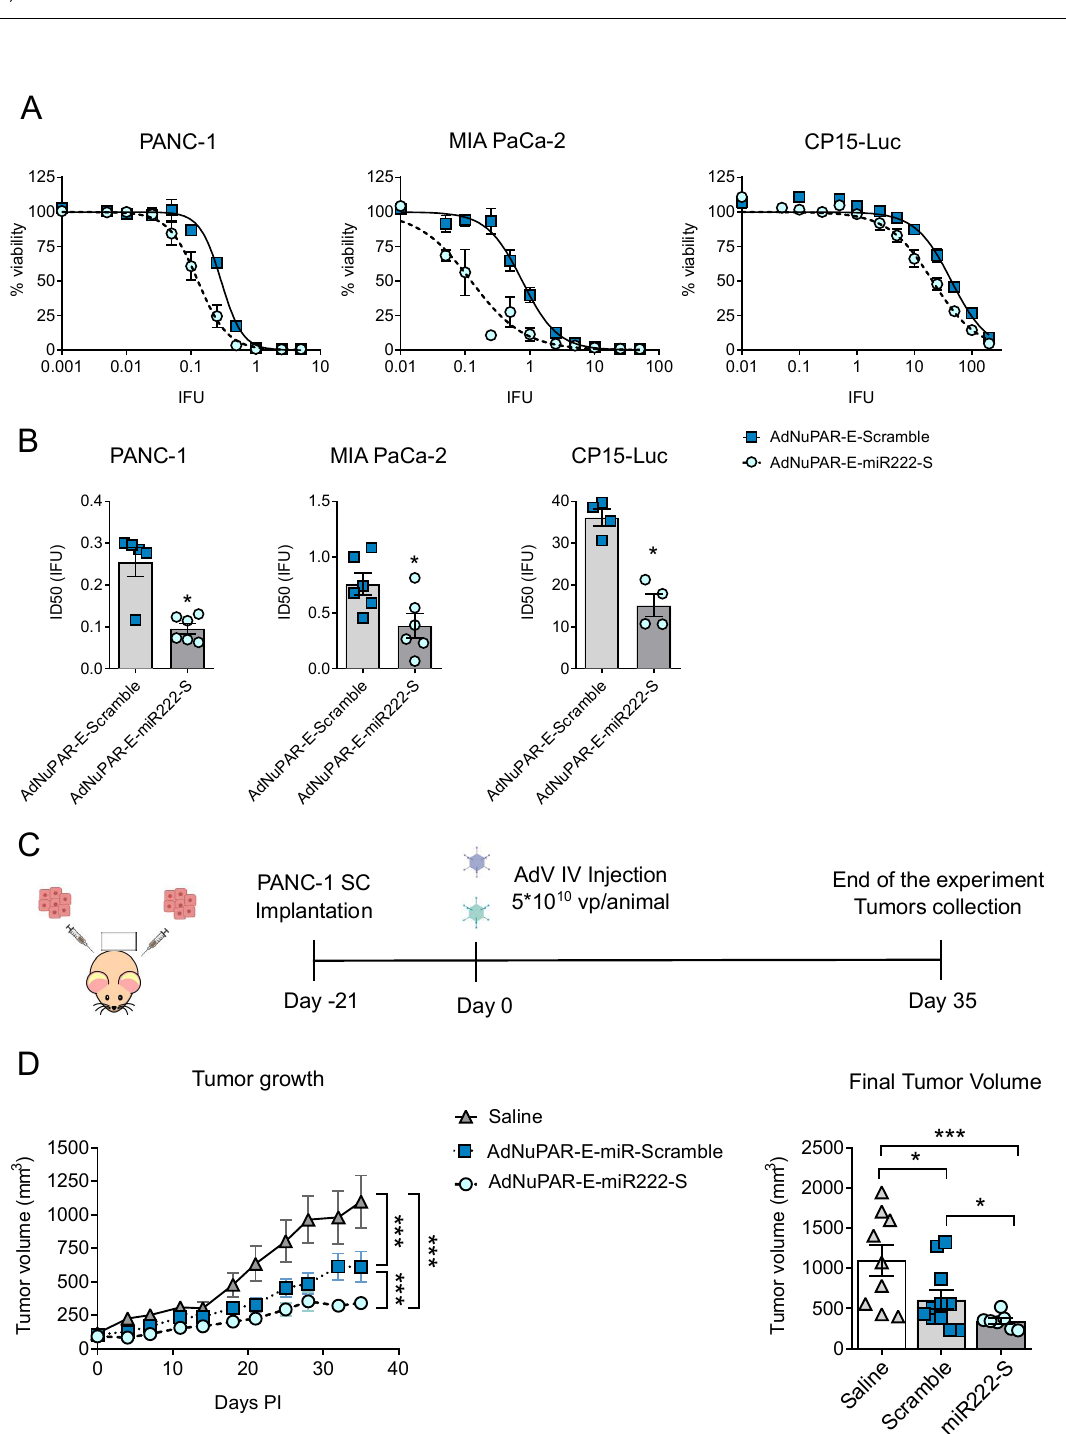
Figure 6. AdNuPAR-E-miR222-S oncolytic potency in vitro and antitumor activity in vivo. ( A ) Viability Curves in PANC-1, MIA PaCa-2, and CP15-Luc cell lines. Cells were infected with AdNuPAR-E-Scramble or AdNuPAR-E-miR222-S at the indicated viral doses and cell viability was measured 7 days later by an MTT assay. ( B ) ID50 values for the three PDAC cell lines. Values are expressed as mean ± SEM of at least four independent biological replicates. ( C ) Schematic representation of the in vivo experiment. ( D ) Tumor growth follow-up. Left panel shows growth curves for the different treatments. Right panel shows mean tumor volumes on day 35 for each group. Data are shown as mean ± SEM. ( n ≥ 8 tumors/treatment group). Statistical differences in tumor growth ( D ) were evaluated using a multiple comparison of means by Tukey contrast, analyzed with the R v.2.14.1 software, applying a linear mixed-effect model using the Ime4 package. p < 0.05 was taken as the level of significance. For the remaining graphs significance was assessed using a two-tailed Mann-Whitney test. * p < 0.05, *** p <